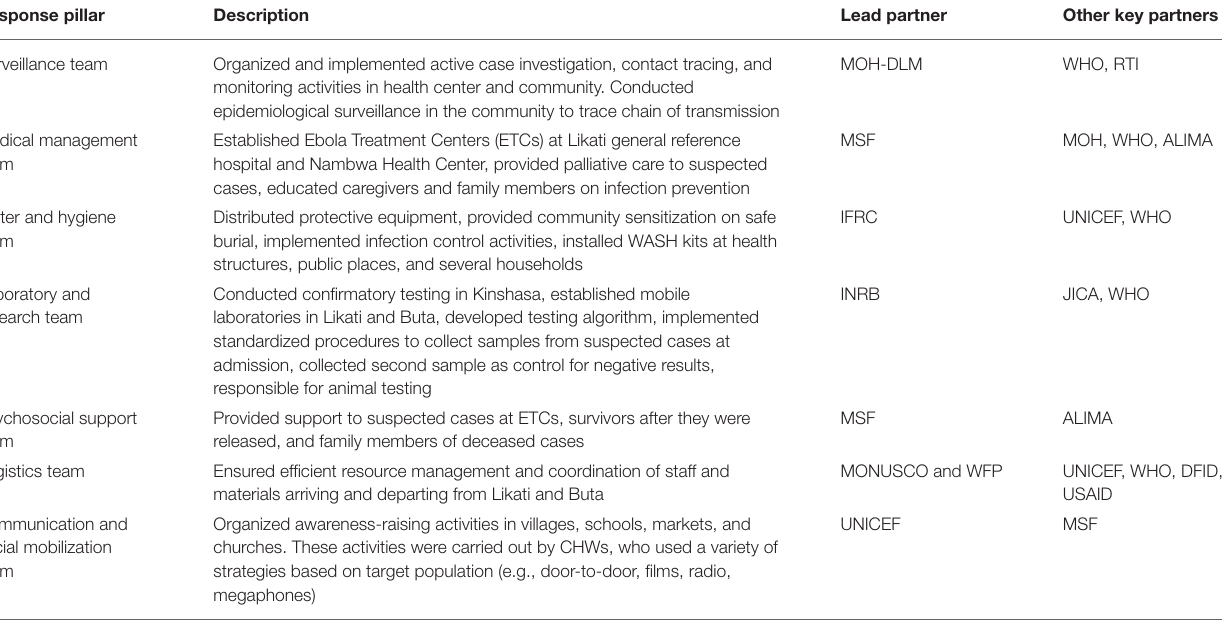
TABLE 1 | Overview of Ebola Rapid Response Teams, Likati Health Zone, DRC, May–June 2017*. Response